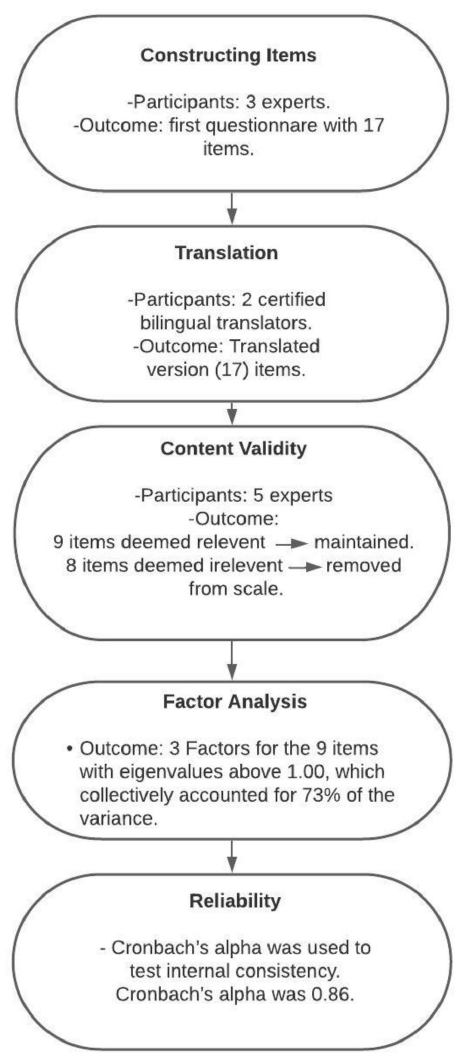
Figure 1. Flowchart of the tool design and validation